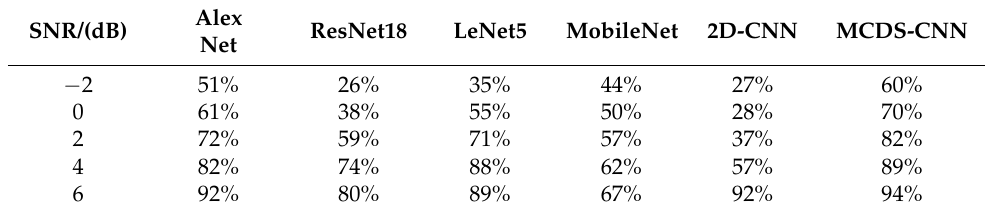
Table 10. Accuracy of the proposed model MCDS-CNN, and other five models on data set C with different